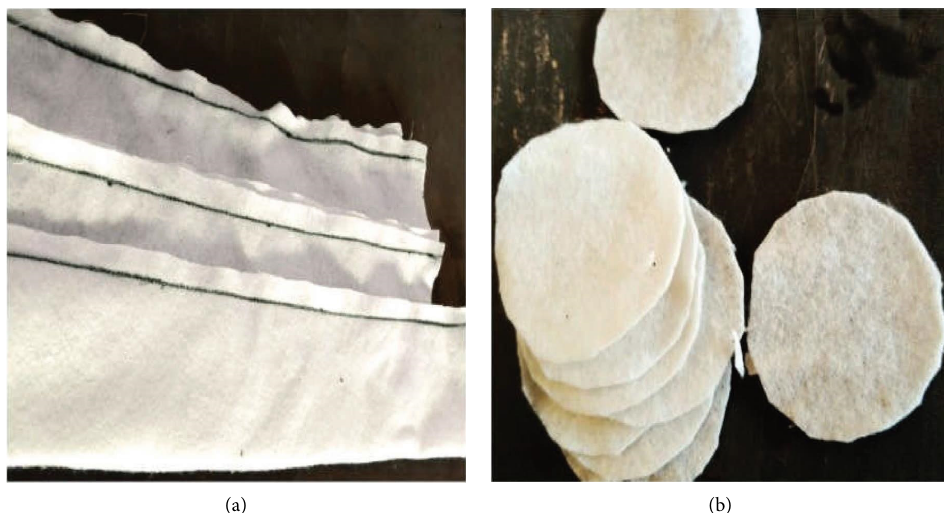
Figure 4: (a) Geotextile for VECGC (vertically encased cinder gravel column), and (b) geotextile disc for HRCGC (horizontally reinforced cinder gravel column).